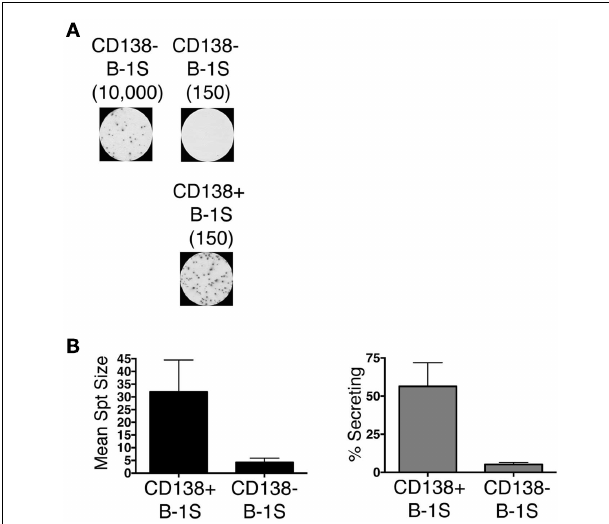
FIGURE 2 | CD138 + and CD138 − splenic B-1a cell IgM secretion in naïve non-immune mice. Sorted splenic CD138 + and CD138 − B-1a cells were evaluated for IgM secretion by ELISPOT. Cells were placed on the ELISPOT membrane for 4h. (A) Representative experiment showing 10,000 or 150 CD138 − cells total placed per well as compared to 150 CD138 + cells total per well. (B) The spots were enumerated to determine mean spot area (black) and the percent of cells secreting IgM (gray). Results shown represent mean values of three independent experiments with lines indicating standard errors of the means.